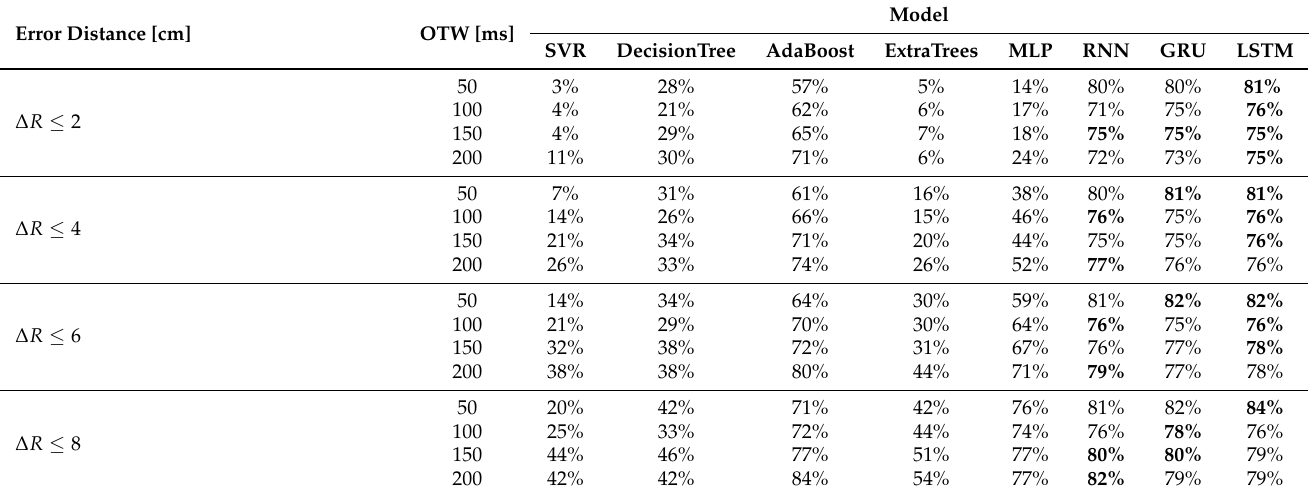
Table 1. Comparison of prediction accuracy for reaching task using different models, with all sensor data. Error Distance [cm] OTW